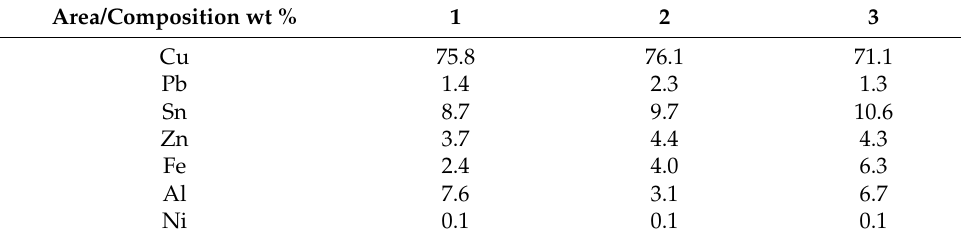
Table 3. Composition of studied locations on MC sculpture (Figure 2) obtained by portable XRF.